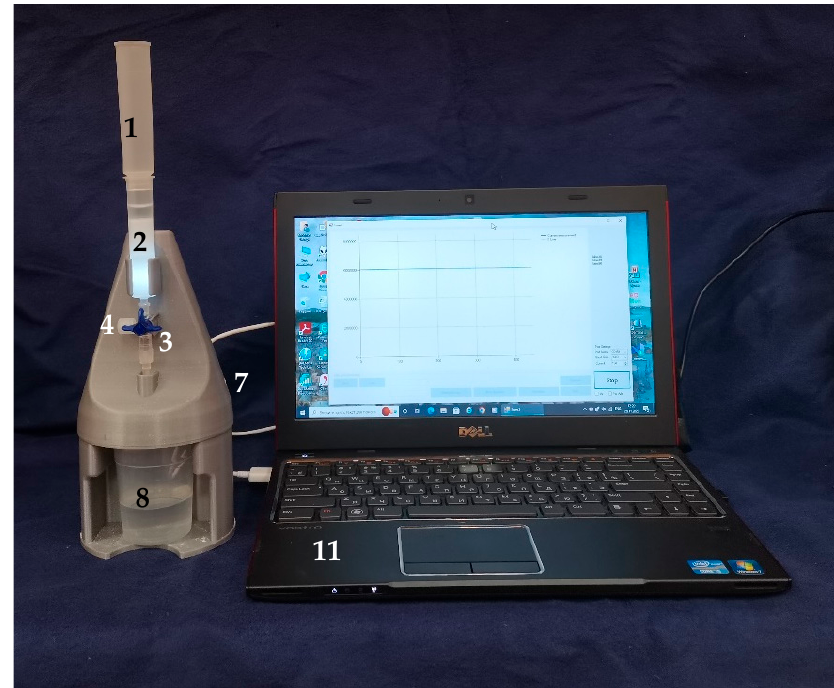
Figure 2. The photo of the sensor.